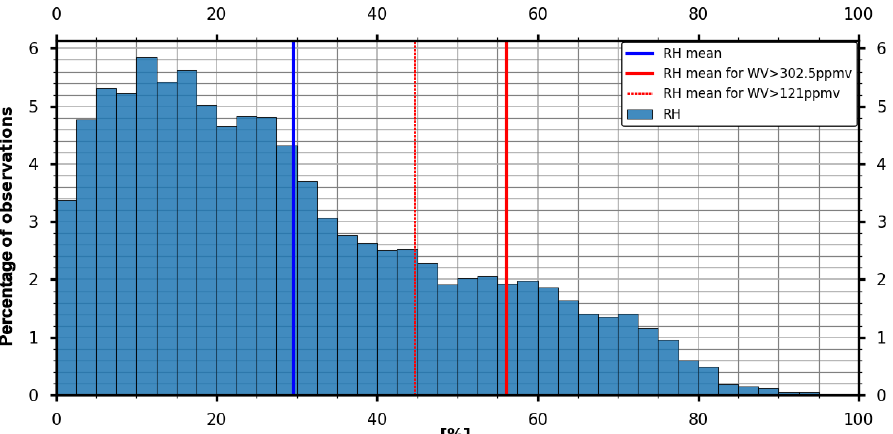
Figure 5. RH distribution in the upper troposphere (10–13km) above Réunion island. The 904 profiles for the period November 2013– April 2016 were used to compute the distribution. Bins are every 5%. The mean RH of the distribution (30.4%) is shown with a blue line, the mean RH for a hydrated profile (WV>121ppmv) with a dotted red line and the mean RH for strong hydration (WV>2 . 5 × 121ppmv) with a red